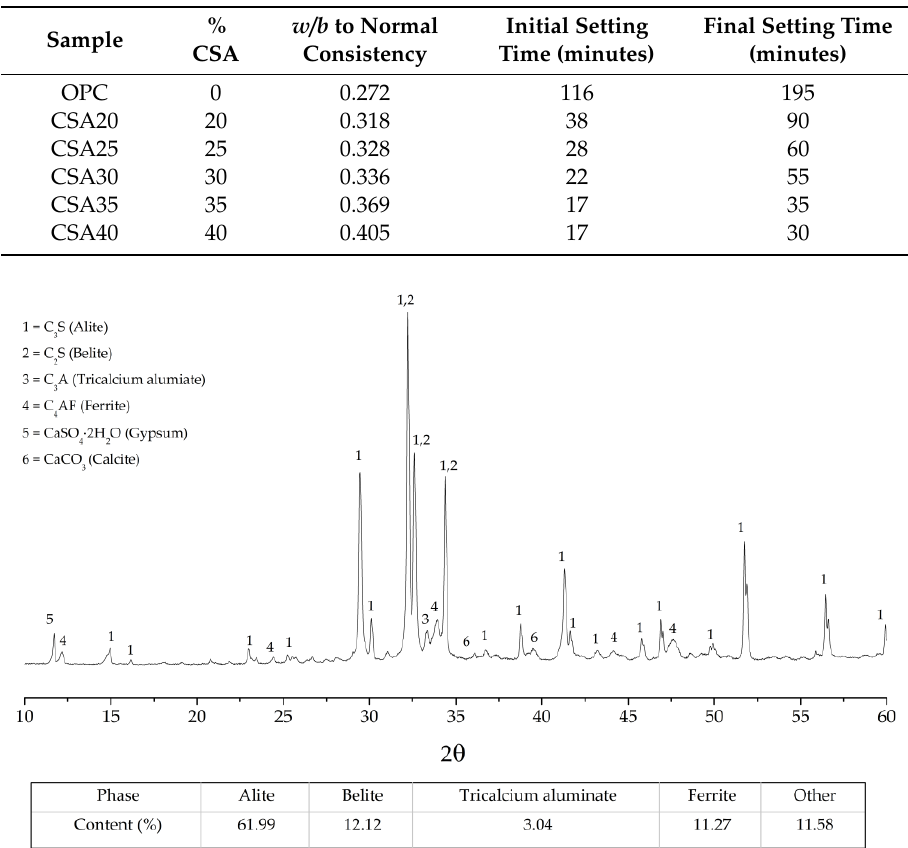
Figure 5. XRD patterns with phase composition of Ordinary Portland cement (OPC). Table 4. Water to binder ratios ( w / b ) to normal consistency and setting times of cement pastes.